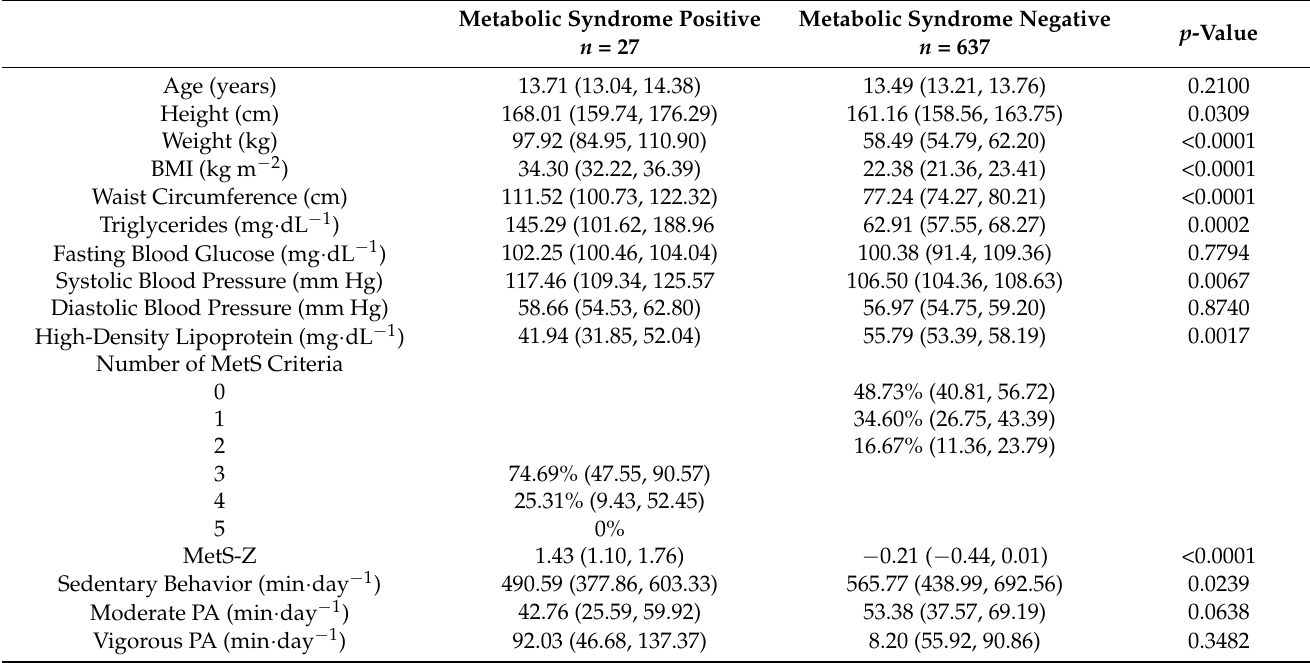
Table 1. Descriptive characteristics—by metabolic syndrome